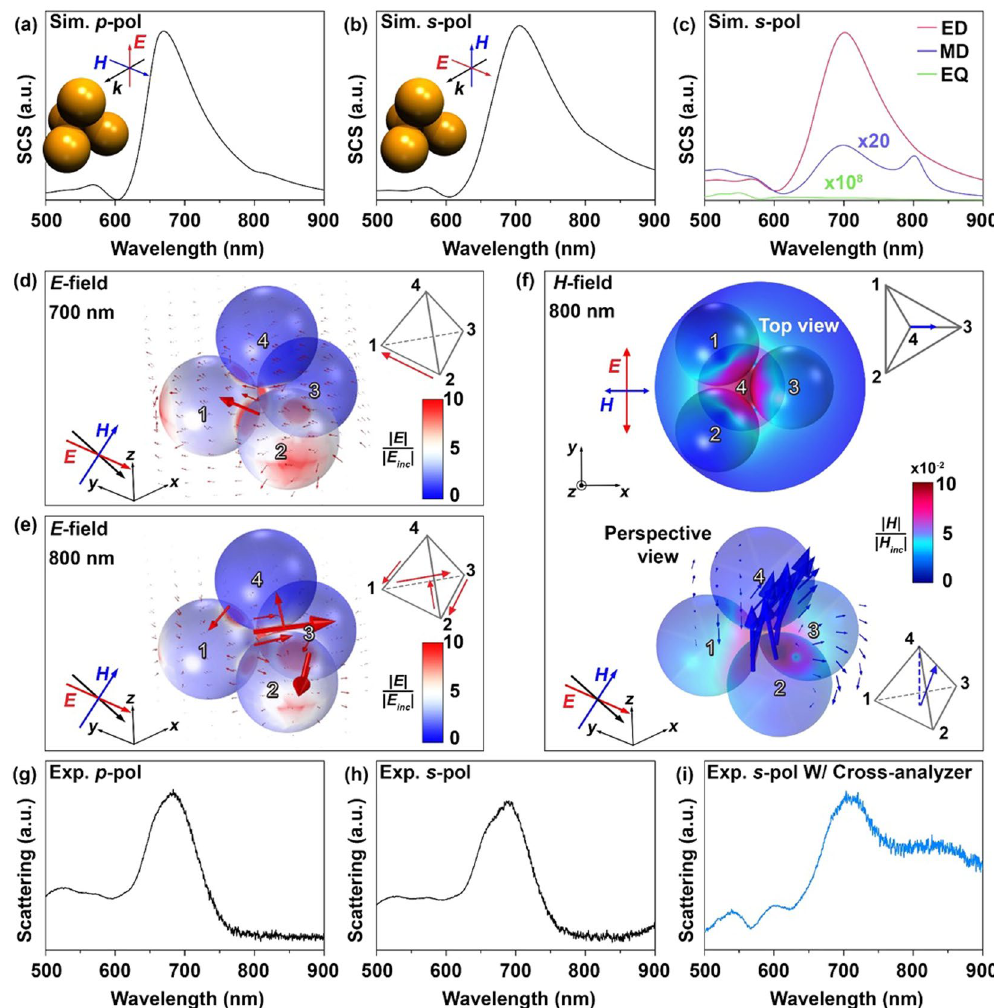
Figure 4. Electromagnetic properties of symmetric tetrahedral cluster. ( a , b ) The theoretical total scattering cross section (SCS) of the symmetric tetrahedral cluster for p - and s -pol illuminations. ( c ) The theoretical SCS analysis of the electric/magnetic dipole (ED/MD) and the electric quadrupole (EQ). The scales of SCS across ( a ), ( b ), and ( c ) are same. ( d ) 3D spatial distribution of the electric field at 700 nm ED resonance. ( e ) 3D spatial distribution of the electric field at 800 nm MD resonance. The red arrows of tetrahedron frames, presented in the insets of ( d ) and ( e ), highlight the orientation of the induced electric field. ( f ) 2D (top panel) and 3D (bottom panel) spatial distribution of the magnetic field at 800 nm MD resonance. The blue arrows of tetrahedron frames (inset of ( f )) indicate the main orientation of the induced MD. ( g , h ) The measured dark- field scattering for p - and s -pol illuminations. ( i ) s -pol dark-field scattering for the same tetrahedral cluster in ( h ), which was filtered by the